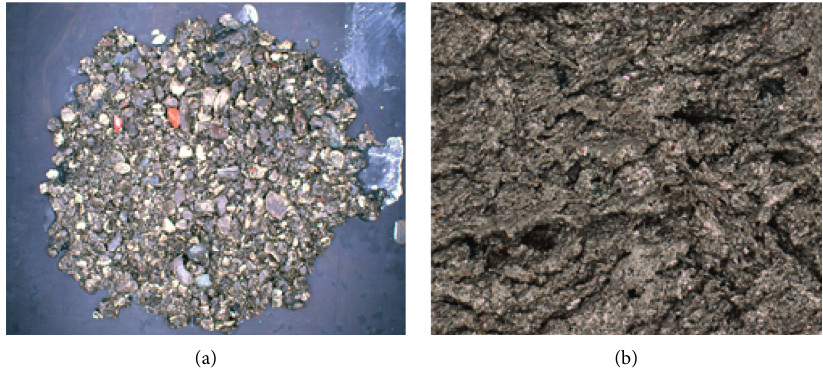
Figure 1: Two kinds of rock images in the dataset. (a) Rock image with boundary. (b) Pure rock images.